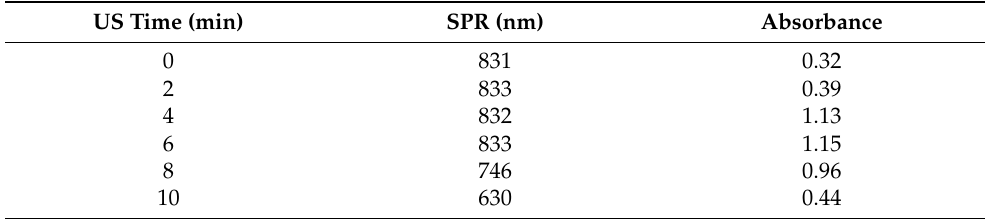
Table 9. The influence of time sonication to surface plasmon resonance and intensity